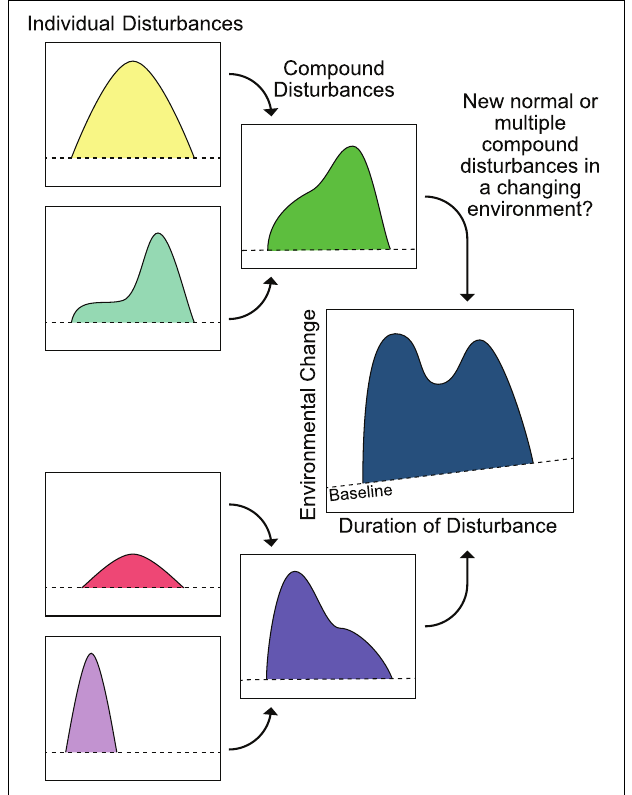
FIGURE 2 | An obstacle to historical paradigms of disturbance theory is that changes in environmental conditions will not only alter the frequency of disturbances, but also the potential for multiple interacting disturbances. As multiple disturbances compound through time, a crucial question emerges: “When does a disturbed state become normal?” Compound disturbances can take many forms and result in both linear and non-linear ecosystem responses. As an example, this figure shows an additive trajectory of disturbances and resultant environmental change. The leftmost panels represent single disturbance events that have long been the targets of scientific research. As disturbances aggregate through time, a new class of ‘compound’ disturbances have been a rising topic (middle panels). With the continuing increases in the frequency and intensity of disturbances, a key challenge remains to disentangle multiple compounding disturbances from normal variability in ecosystem functions (rightmost panel). Another challenge is that environmental baselines (dashed line) shift through time, adding a chronic component to the study of short-term disturbance